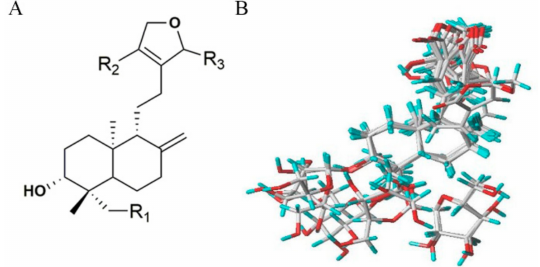
Figure 4. ( A ) The common skeleton for the alignment. ( B ) The alignment of all the compounds used in the data